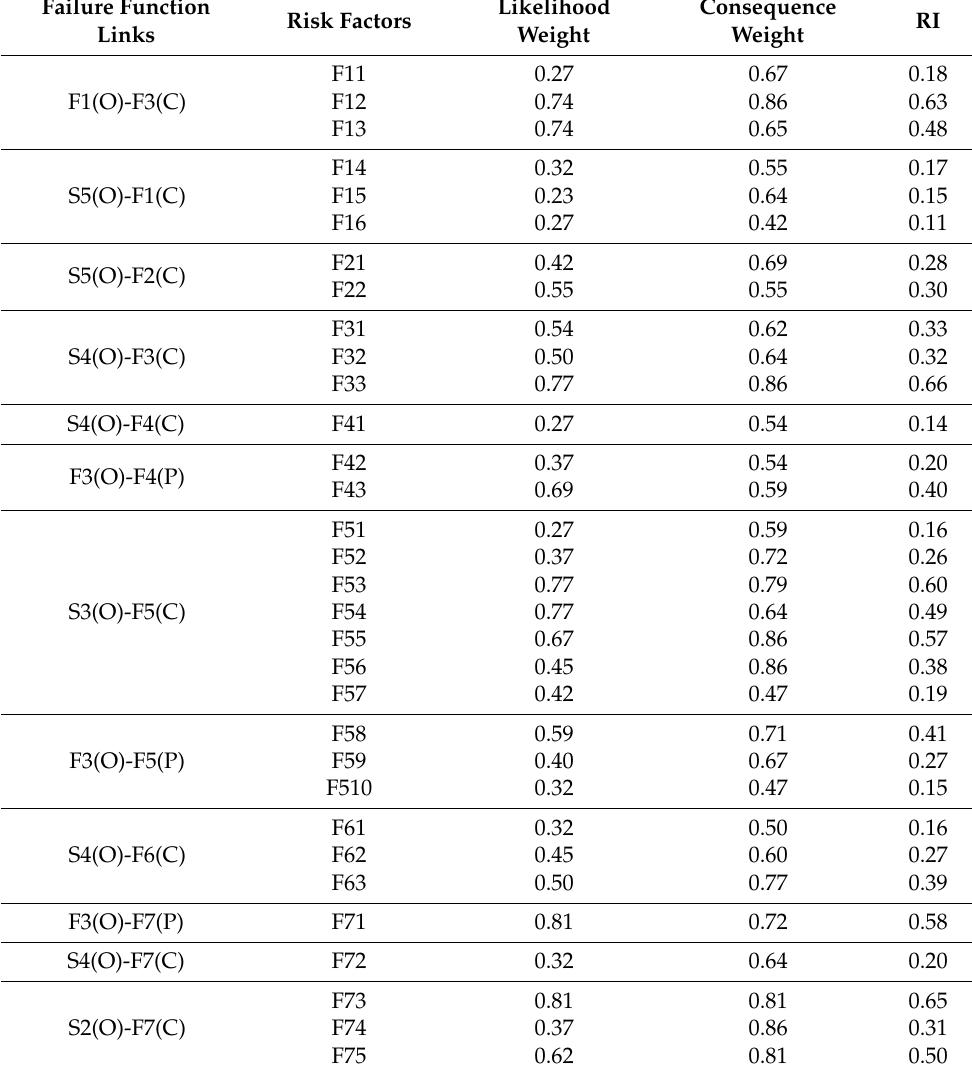
Table 4. RI of the risk